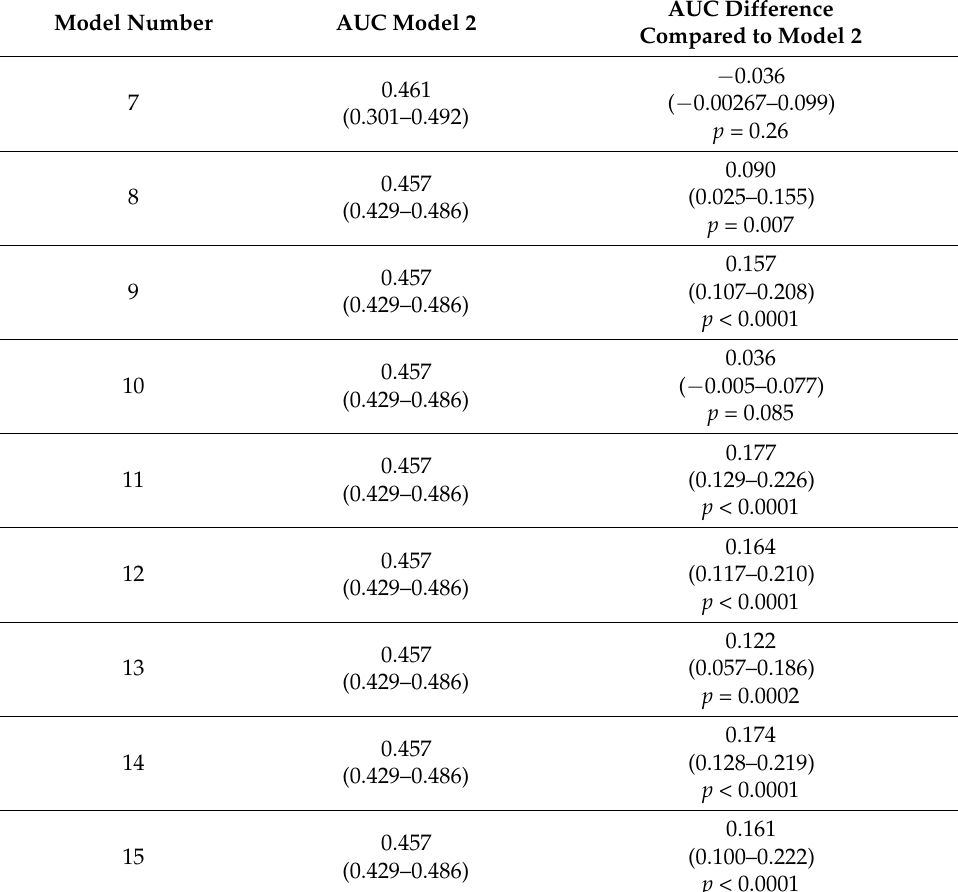
Table S2 rs2612091 and rs12132152 have to be analysed separately to the DPYD deficiency alleles to avoid poor prediction of the other 5-FU related toxicities. Table 4. Comparative ROC analysis of models for the prediction of